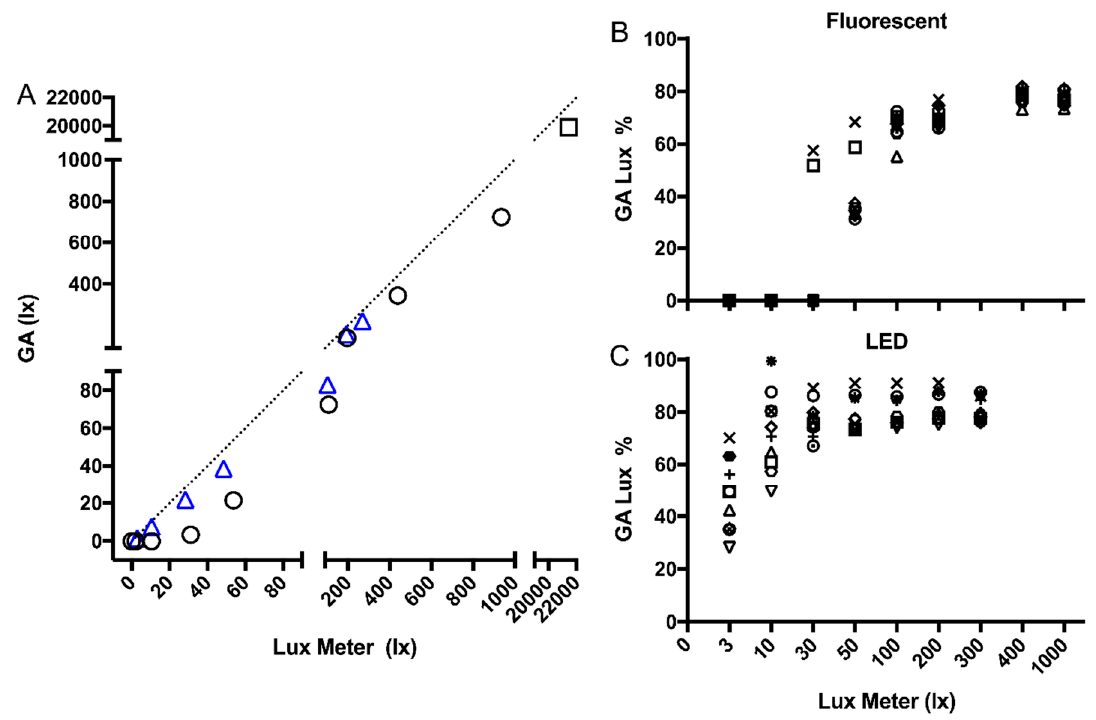
Figure 2. Linearity test of GENEActivs under fluorescent and LED bulbs, and outdoors. ( A ) Mean GENEActiv lux under fluorescent light (circles), LED light (triangles), and outdoor overcast light (square). Dotted line represents perfect agreement. ( B ) GENEActiv lux ( n = 10) relative (%) to the lux meter under fluorescent light; each symbol represents one device. ( C ) GENEActiv lux ( n = 10) relative (%) to the lux meter under LED light; each symbol represents one device. Table 2. Summary statistics across n = 10 GENEActiv devices under broad-spectrum white fluorescent and LED light sources.